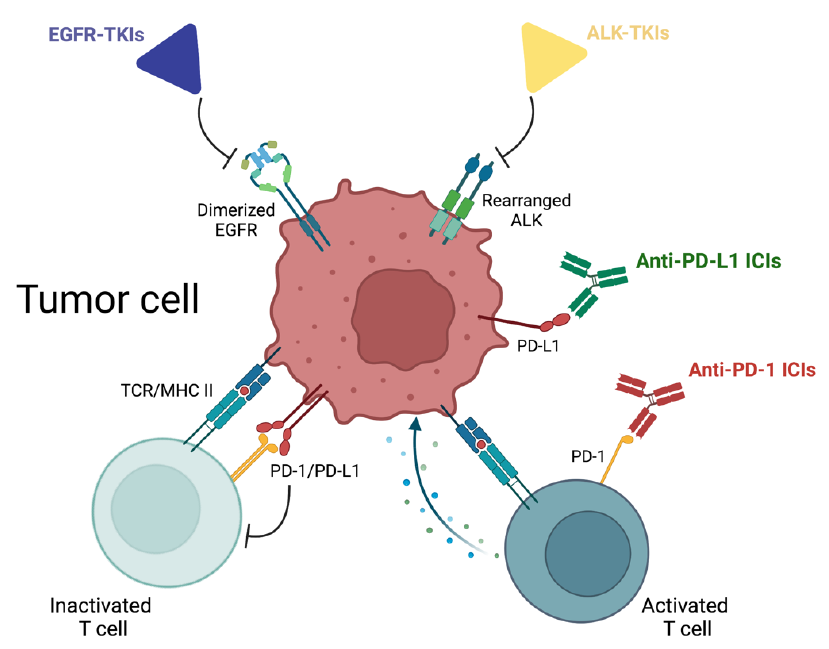
Figure 1. Mechanisms of action of main drugs evaluated in the adjuvant and neoadjuvant setting in NSCLC patients (created with BioRender.com (accessed on 15 June 2022)). Abbreviations: EGFR, Epidermal Growth Factor Receptor; ALK, Anaplastic Lymphoma Kinase; TKIs, tyrosine kinase inhibitors; PD-(L)1, Programmed death-(ligand) 1; ICIs, immune checkpoint inhibitors; TCR, T-cell receptor; MHC II, major histocompatibility complex.